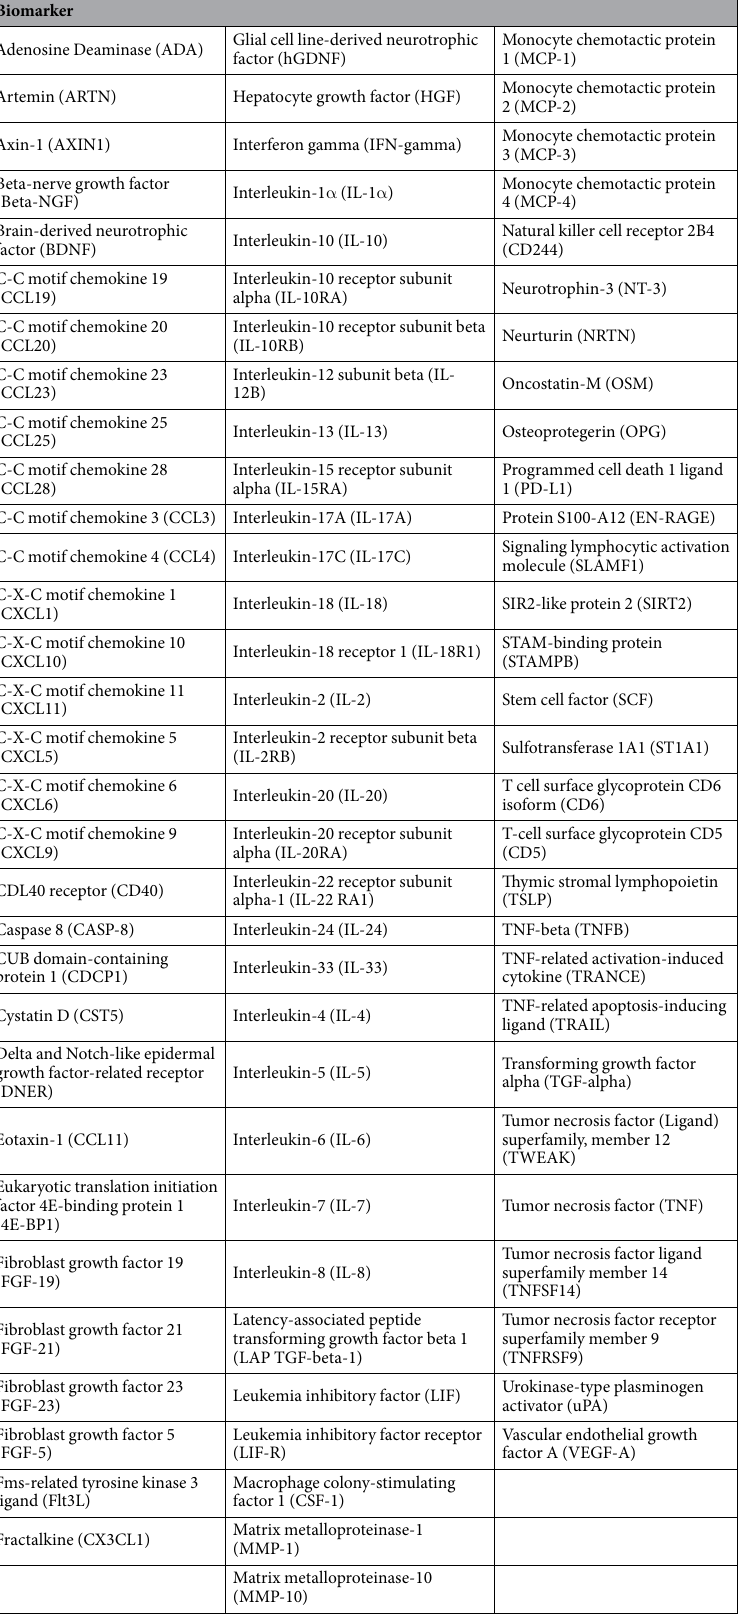
Table 4. Biomarkers analysed with the Proseek proximity extension